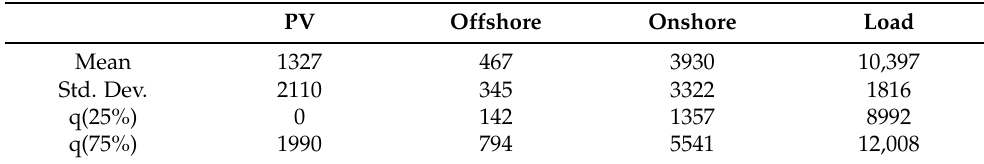
Table 2. Hourly forecast data in MW from 1 October 2018 to 31 December 2021.